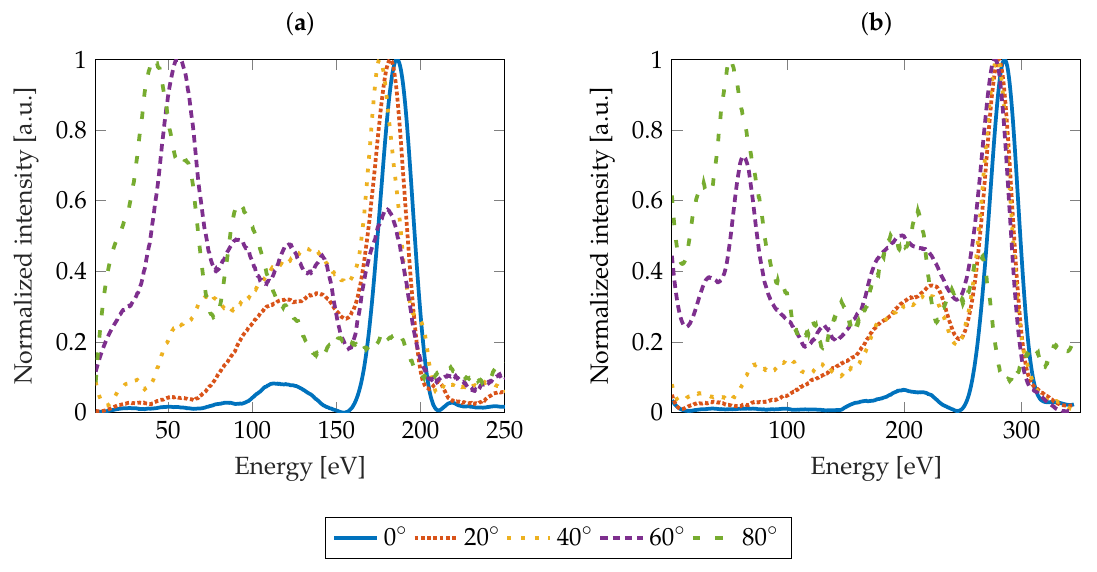
Figure 10. IEDF at different discharge voltages, 200 V ( a ) and 300 V ( b ), for constant anode mass flow rate (5 sccm). Curves are plotted for five different